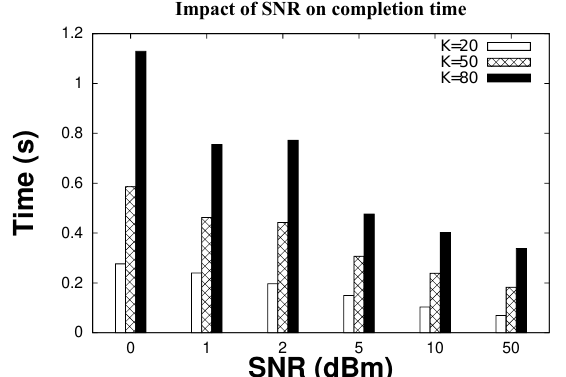
Figure 10. Completion time with varying